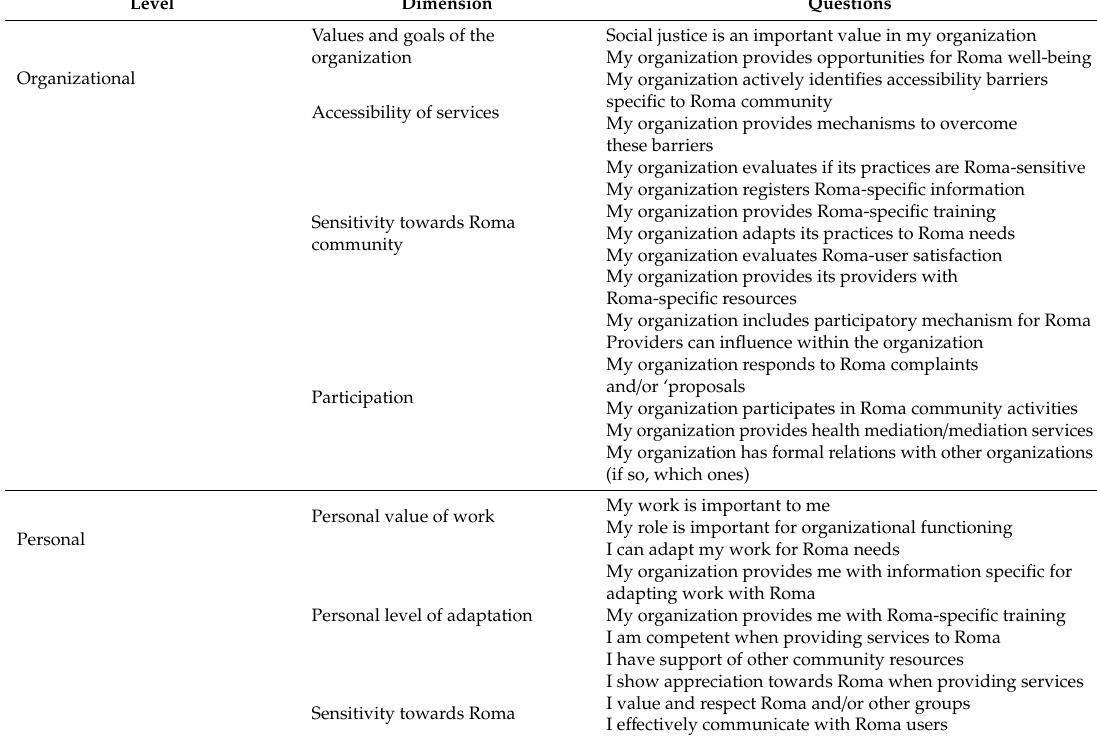
Table A2. Organizational and health care provider survey for local Roma